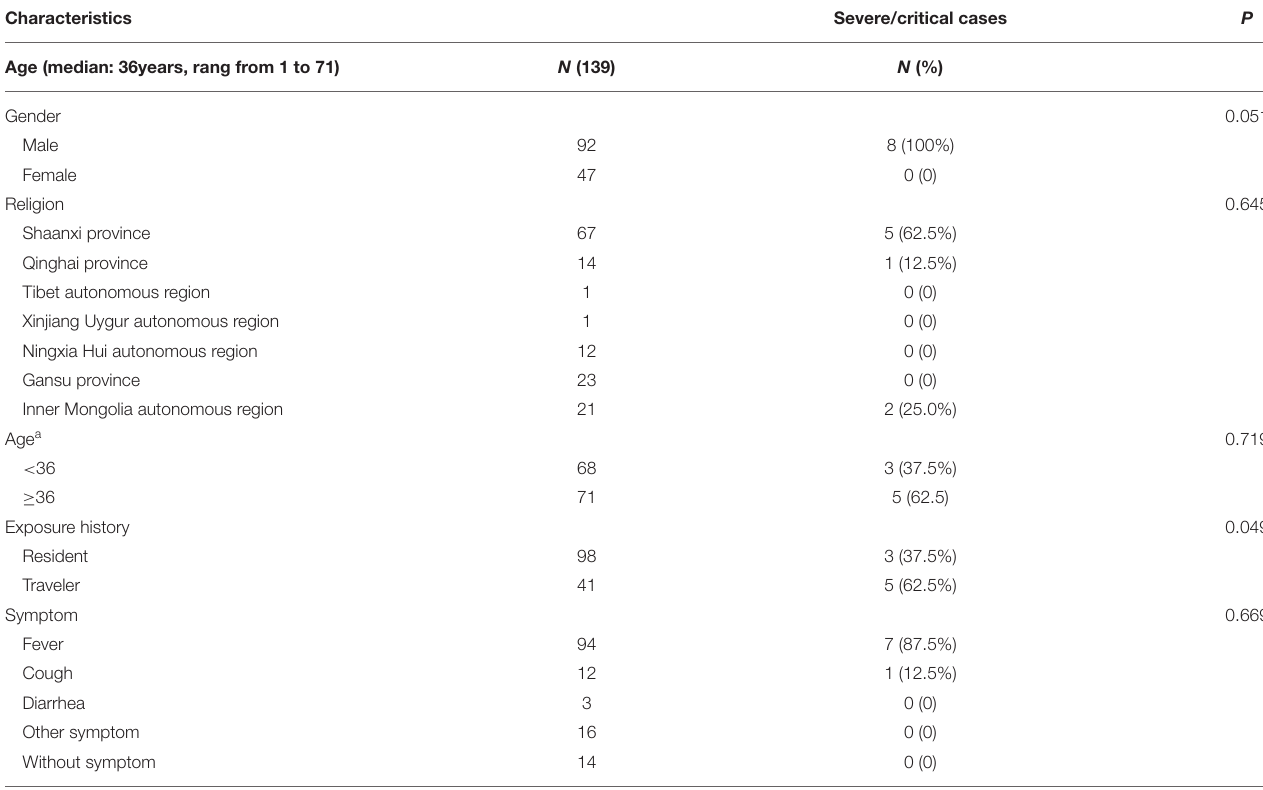
TABLE 1 | Association between clinical characteristics and severity status of patients diagnosed with COVID-19. Characteristics Severe/critical cases